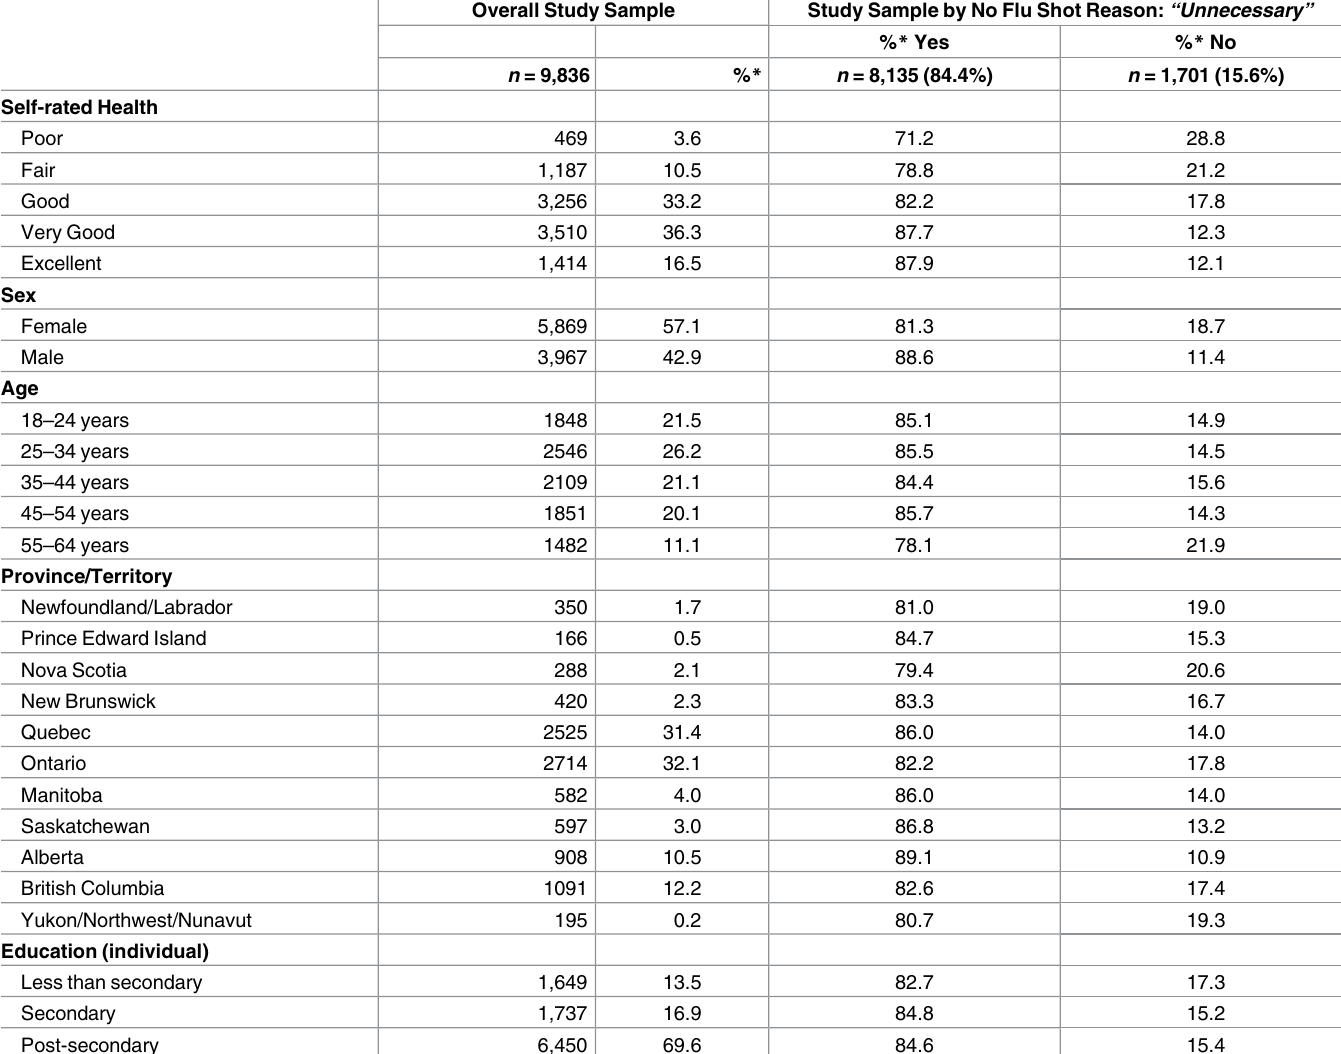
Table 1. Characteristics of Canadian Community Health Survey pooled CCHS cycles 3.1(2005),2007/08, 2009/10, 2011/12, examining the associa- tion between self-reported health and the reasons for non-vaccination against seasonal influenza among Canadian adults with